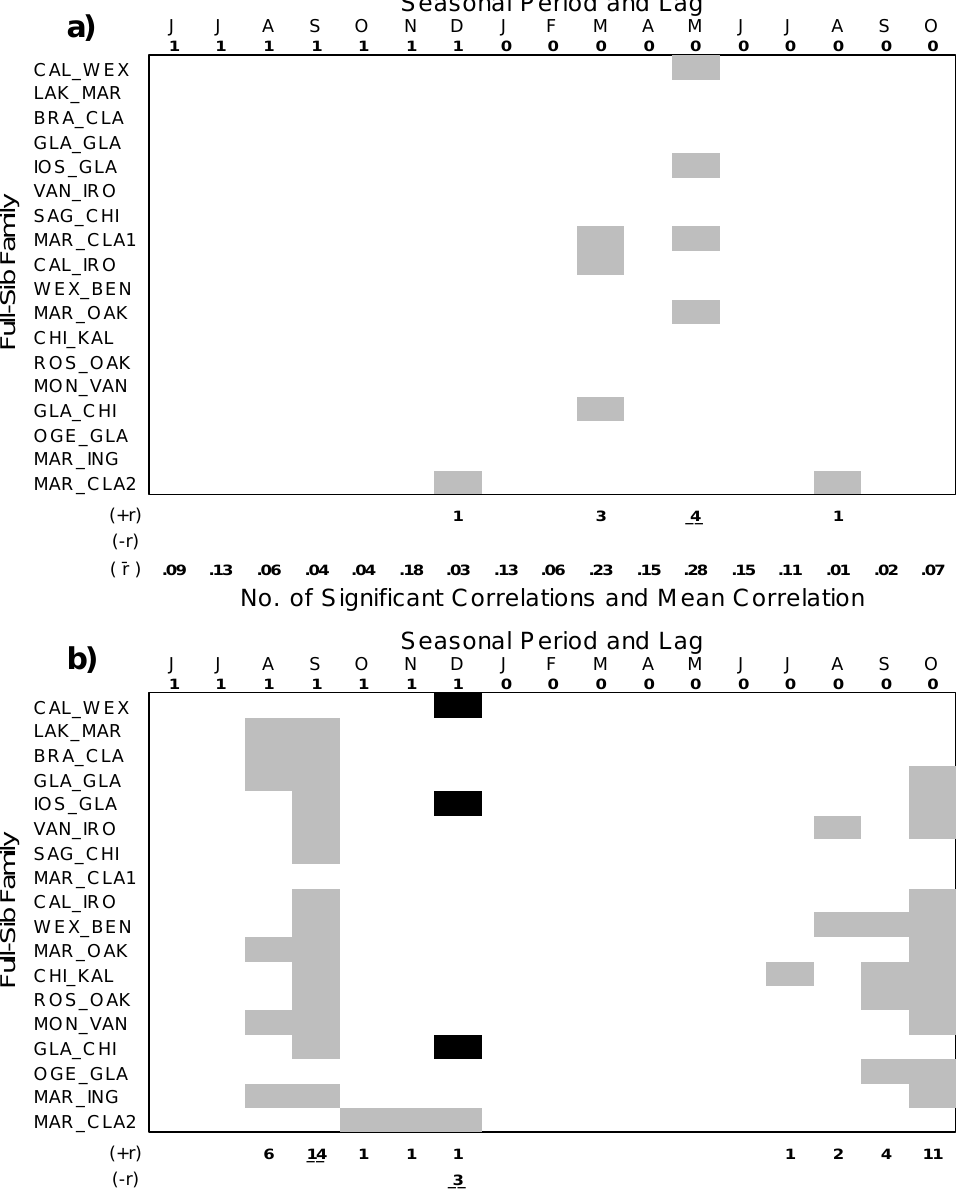
Figure 5. Pearson’s correlation coefficients between the standardized basal area index (BAI) growth chronologies of all 18 full-sib families of hybrid poplar ( P. × smithii ) with seasonal (3 month periods) climate variables: (a) mean temperature; and (b) total precipitation. The analysis was conducted from 1987-2008 and all possible 3 month periods were considered that spanned two growing seasons from April of the prior year (lag 1 = t − 1) to October of the current year (lag 0 = t). The monthly abbreviations indicate the month at which a 3 month period ends. Significant (P < 0.05) positive relationships denoted by gray boxes, and significant (P < 0.05) negative relationships indicated by black boxes. The number of significant positive and negative correlation coefficients are shown below each figure with the highest number for each underlined. The mean correlation coefficient for each month is also